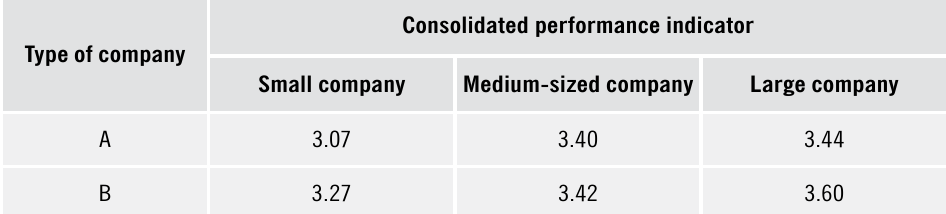
Table 8. Consolidated performance indicator according to company size and type